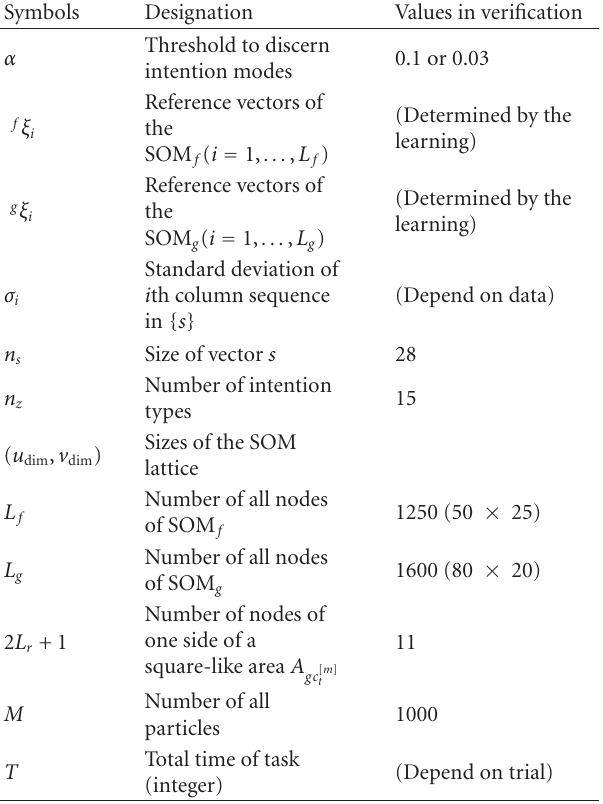
Table 3: List of